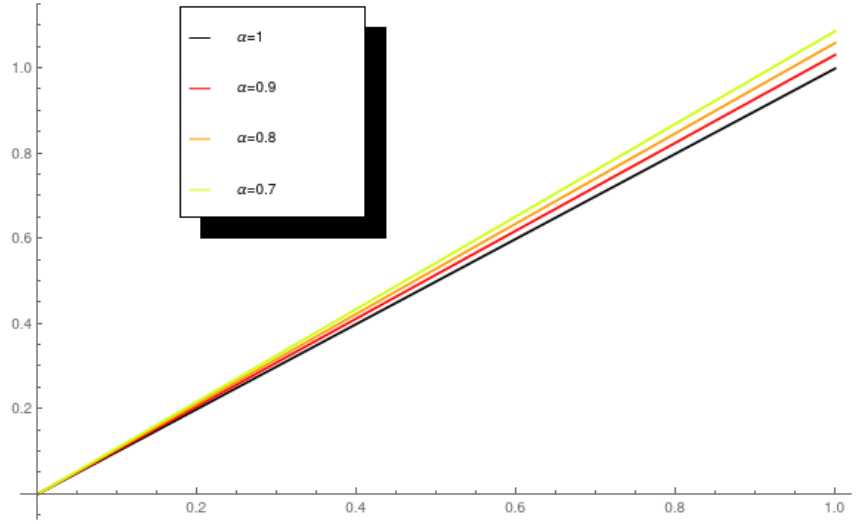
Figure 2. Approximate solutions of (18) for several values of α